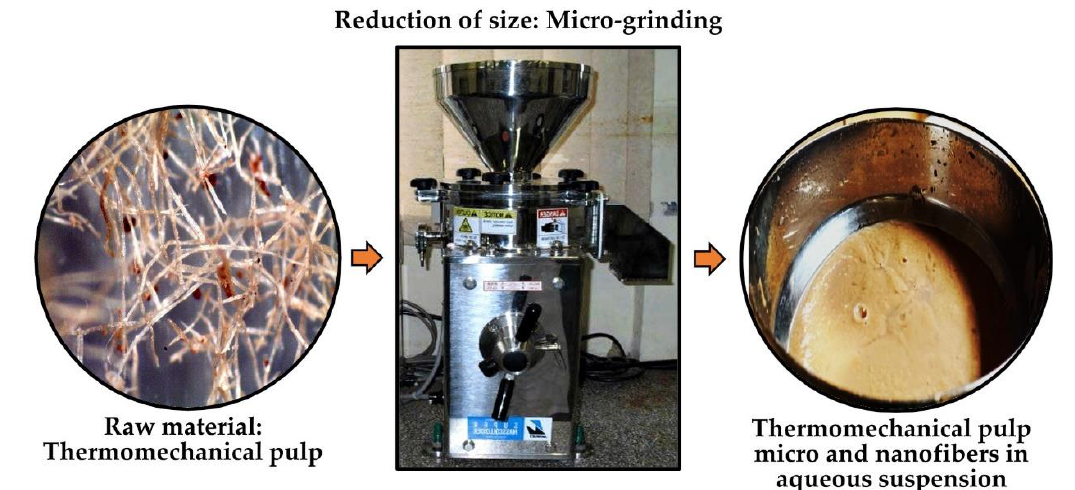
Figure 1. Scheme. TMP-NF production.